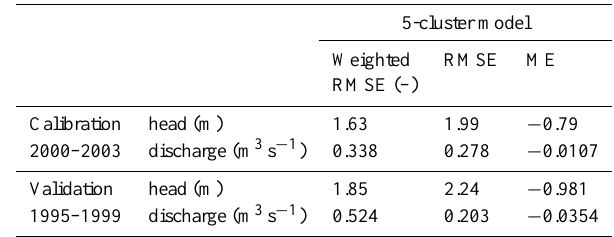
Table 1. Calibration and validation statistics for the temporally split sample consisting of observations from 35 wells, which have obser- vations both in the calibration and validation period, and discharge stations 270003 and